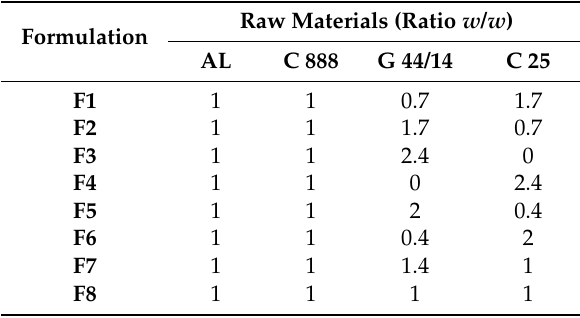
Table 1. Composition of AL-loaded